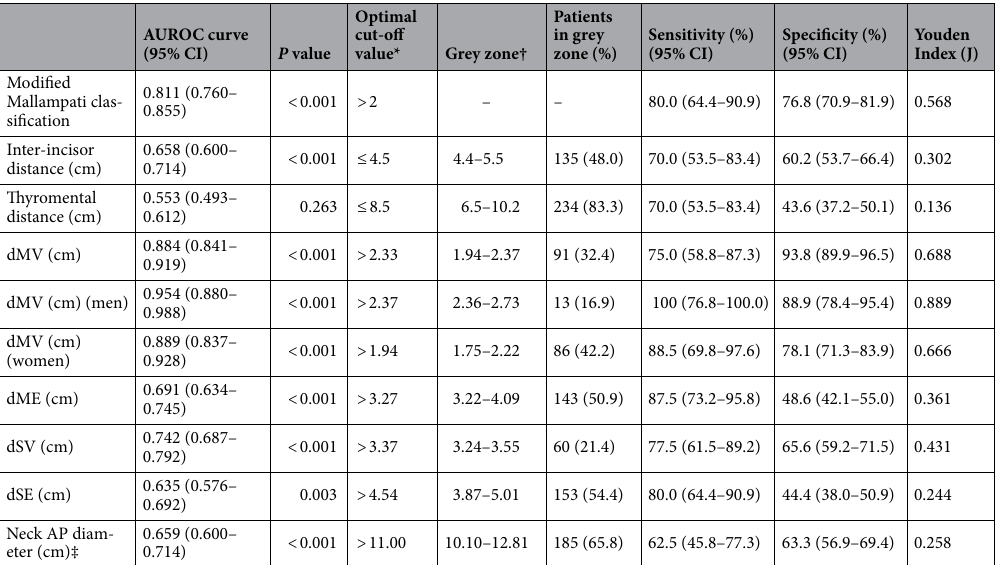
Table 2. Prediction of difficult laryngoscopy by the receiver operating characteristic curves of the airway parameters. AP, anterior–posterior; AUROC, area under the receiver operating characteristic; CI, confidence interval; dME (membrane-to-epiglottis distance), distance from the midpoint of the thyrohyoid membrane between the hyoid bone and laryngeal prominence to the furthermost tip of the epiglottis; dMV (membrane- to-vallecula distance), distance from the midpoint of the thyrohyoid membrane between the hyoid bone and laryngeal prominence to the closest concave point of the vallecula; dSE (skin-to-epiglottis distance), extended distances straight to the skin anterior from the dME; dSV (skin-to-vallecula distance), extended distances straight to the skin anterior from the dMV. *Optimal cut-off values are determined by maximising the Youden index. † Grey zone: based on 1000 bootstrap samples, 95% CIs of the best threshold are determined. ‡ One patient from the non-difficult laryngoscopy group is excluded because of missing neck AP diameter data due to the impossibility of measurements owing to a tracheal deviation by mass.